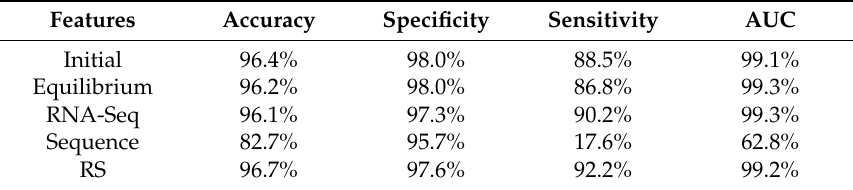
Table 1. Performance comparison of different features with Random Forest.